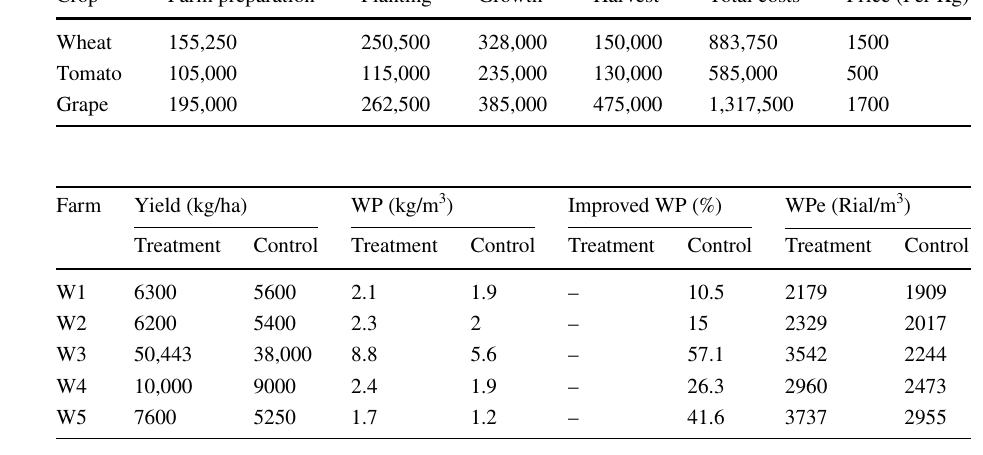
Table 7 Costs of different stages of planting and the guaranteed purchase price of crops (unit 10 Rials)